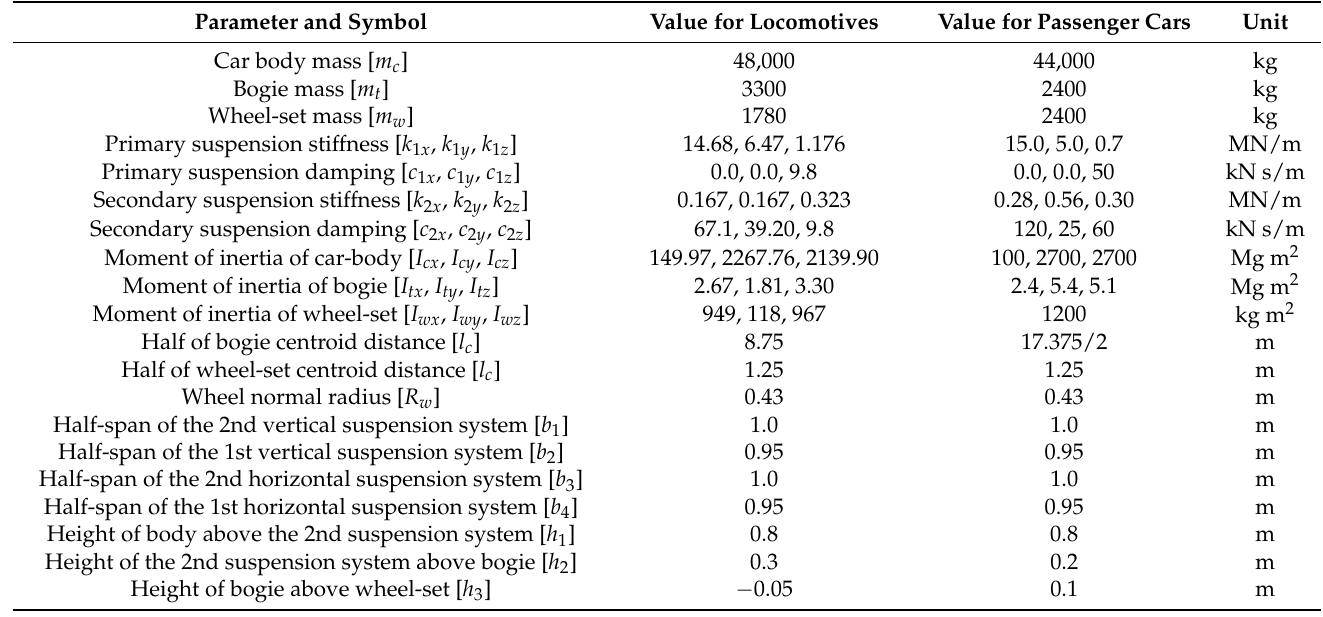
Table A1. Railway vehicle parameters used in the numerical